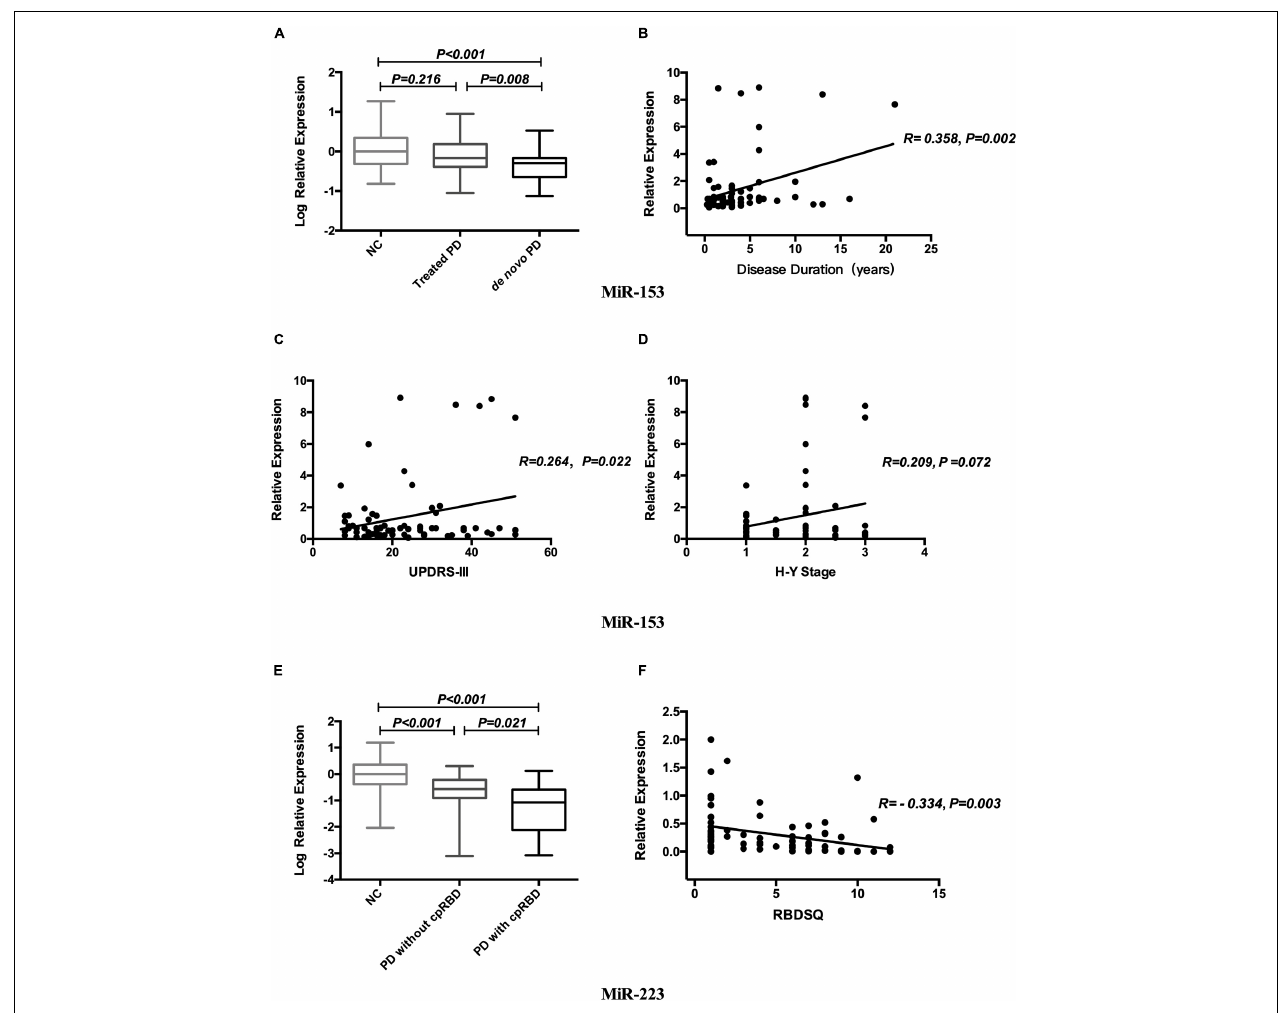
FIGURE 2 | Relationship between miR-153, miR-223, and clinical phenotype in PD. Expression levels of miR-153 in NCs treated PD and de novo PD groups (A) . Correlation analysis between miR-153 and disease duration (B) . Correlation analysis between miR-153 and UPDRS-III (C) . Correlation analysis between miR-153 and H&Y stage (D) . Expression levels of miR-223 in NCs, PD with cpRBD, and PD without cpRBD groups (E) . Correlation analysis between miR-223 and RBDSQ (F) . NCs, normal controls; miR, microRNA; PD, Parkinson’s disease; UPDRS-III, Unified Parkinson’s Disease Rating Scale part III; H&Y stage, Hoehn and Yahr stage;